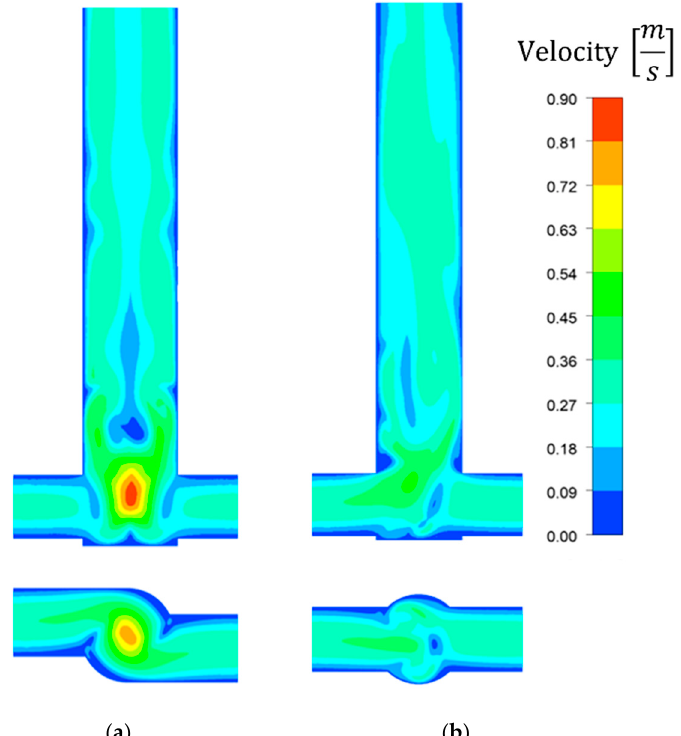
Figure 8. Comparison of velocity [m s − 1 ] contour plots for 0.6 mol/dm 3 AS and 20 mL/min flow rate in ( a ) V- and ( b ) T-type reactors.